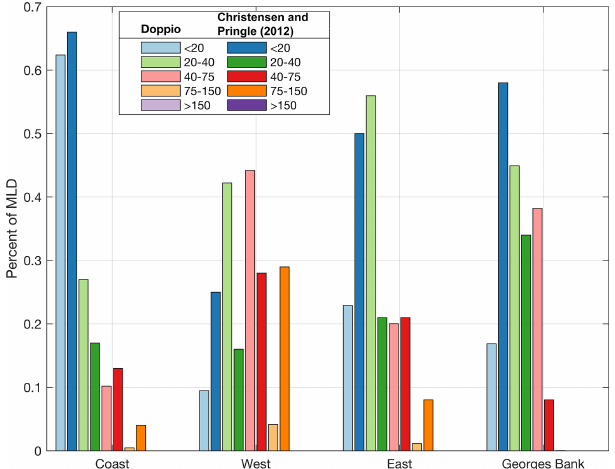
Figure 14. Comparison of frequency of occurrence of mixed-layer depths (modeled and observed) for zones in the Gulf of Maine and Georges Bank. MLD definition and specific zones follow Chris- tensen and Pringle